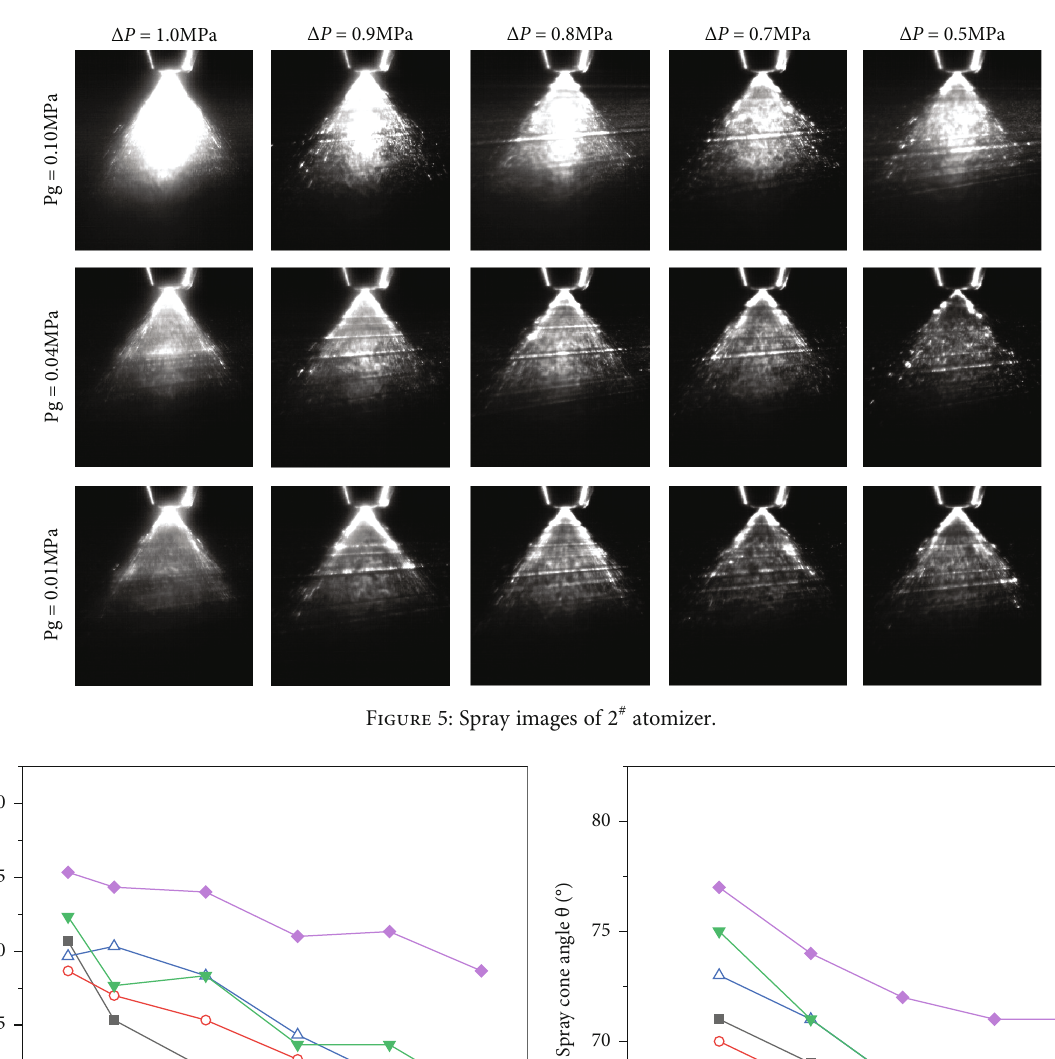
Figure 5: Spray images of 2 #